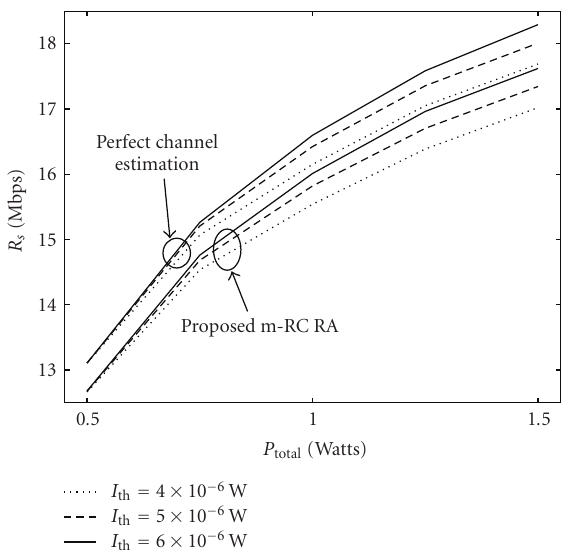
Figure 1: Total bit rate, R s , as a function of P total with I th = 6 × 10 − 6 W.